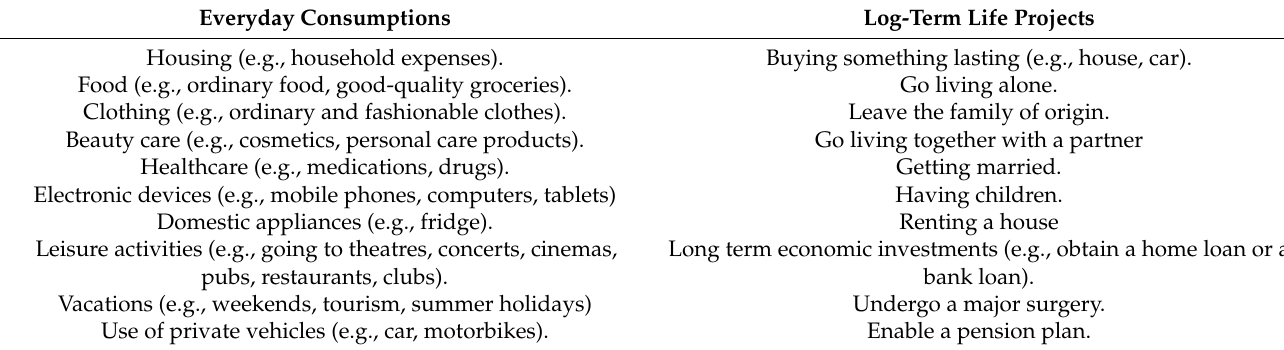
Table 1. Example of items about consumer decisions, see also